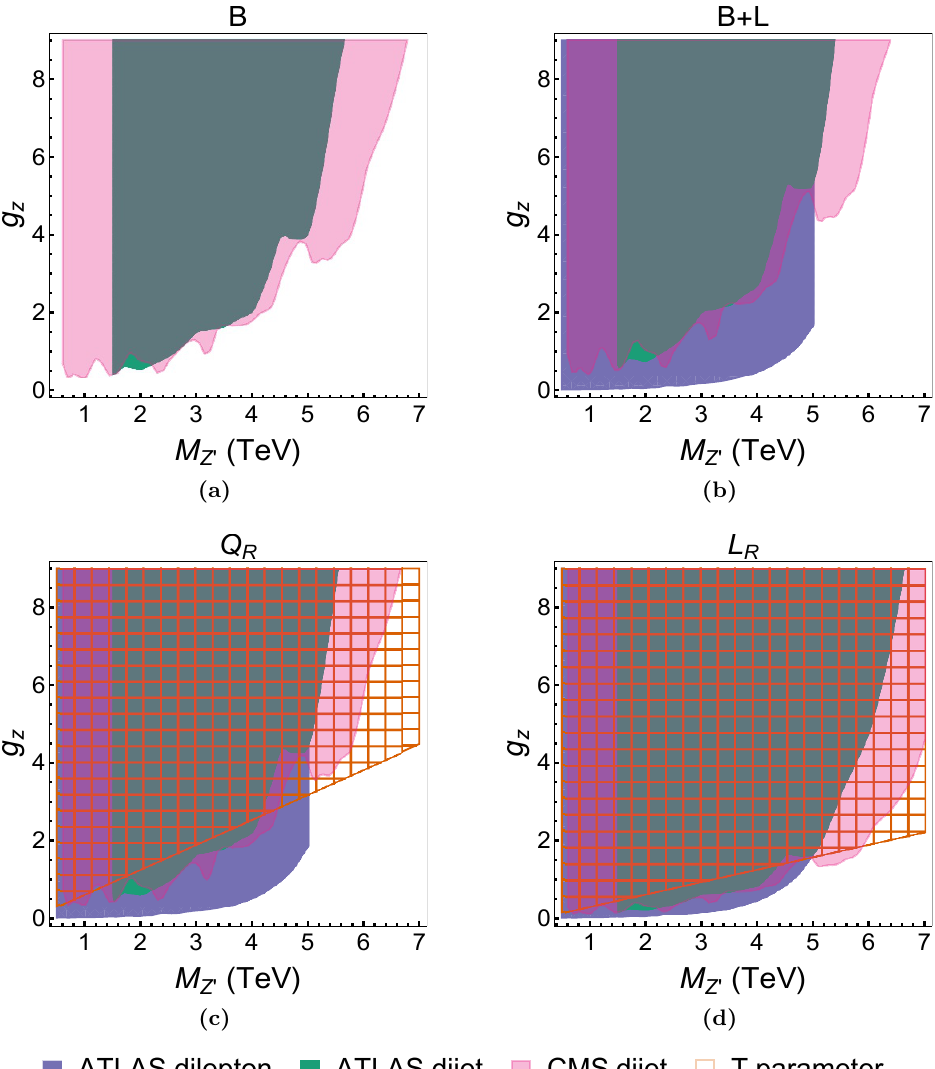
Figure 3. The marked regions are excluded from various experimental constraints. The lilac (cid:12)lled region corresponds to R > 1, where R = ( (cid:27) (cid:2) BR ll ) th = ( (cid:27) (cid:2) BR ll ) obs and ( (cid:27) (cid:2) BR ll ) th and ATLAS ( (cid:27) (cid:2) BR ll ) obs denote our prediction and the observed 95% CL upper limit set by ATLAS using ATLAS dilepton resonance search data at the 13 TeV LHC [38], respectively. The (cid:12)lled teal region is the similar comparison with the 13 TeV ATLAS dijet data [39]; the transparent magenta region is the corresponding comparison with the 13 TeV CMS dijet data [40]. The orange/red grid-covered region is excluded from the T -parameter